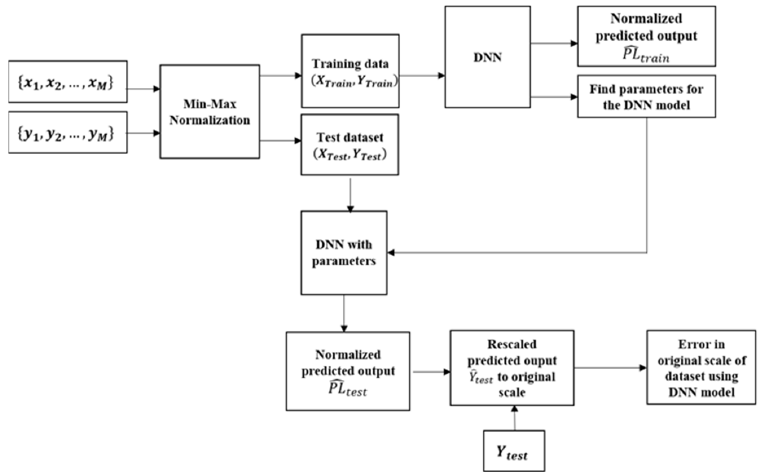
Figure 5. Block diagram of the processing data using proposed DNN